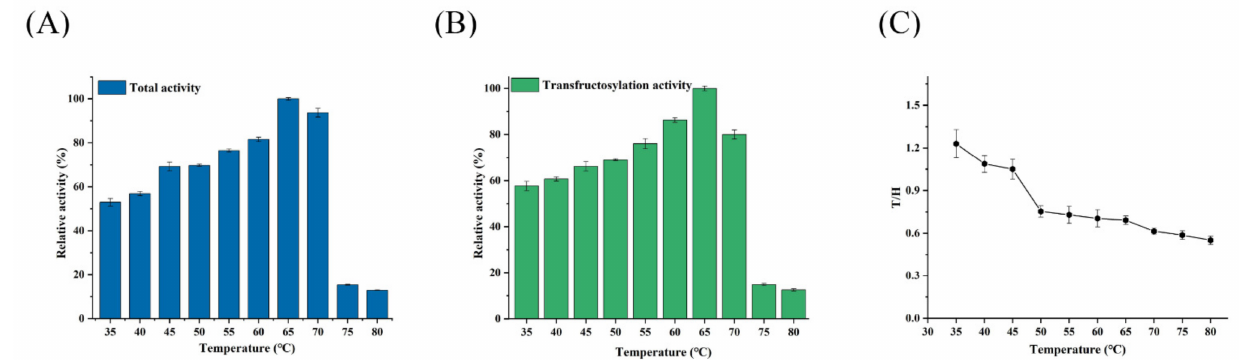
Figure 4. Effect of temperature on the activity and T/H of the recombinant LS. ( A ) Effect of temper- ature on the total activity of Psor-LS. ( B ) Effect of temperature on the transfructosylation activity of Psor-LS. ( C ) Effect of temperature on the T/H of Psor-LS. All of the values were the mean of triplicate